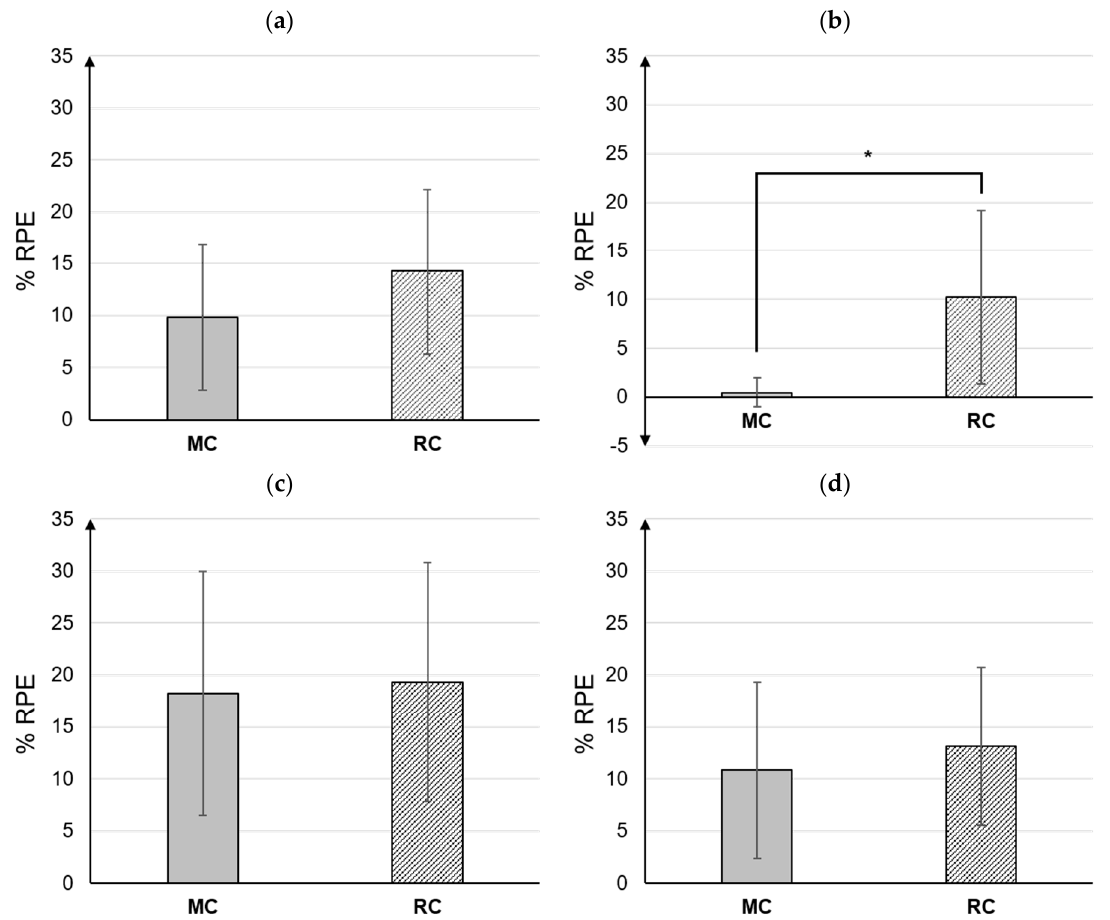
Figure 7. The comparison of subjective physical discomfort between MC and RC: ( a ) Total MC vs. Total RC, ( b ) Preparation MC vs. Preparation RC, ( c ) Front MC vs. Front RC, and ( d ) Post MC vs. Post RC. Note * p < 0.05.